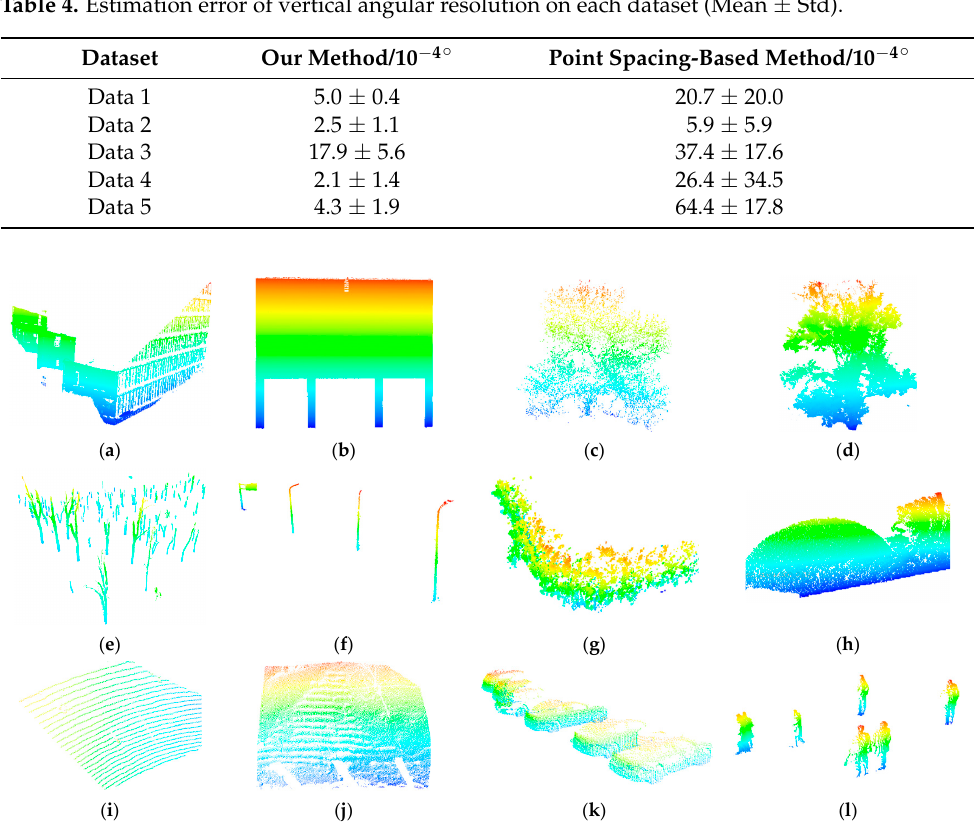
Table 5. Estimation error of different types of objects.